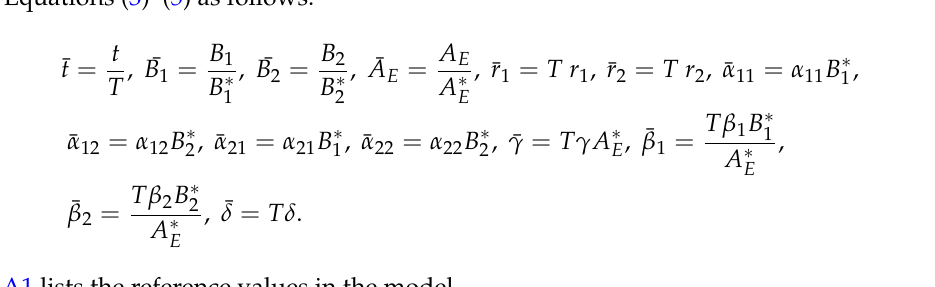
Table A1 lists the reference values in the model. Table A1. Reference value. tw = estimated in this work.